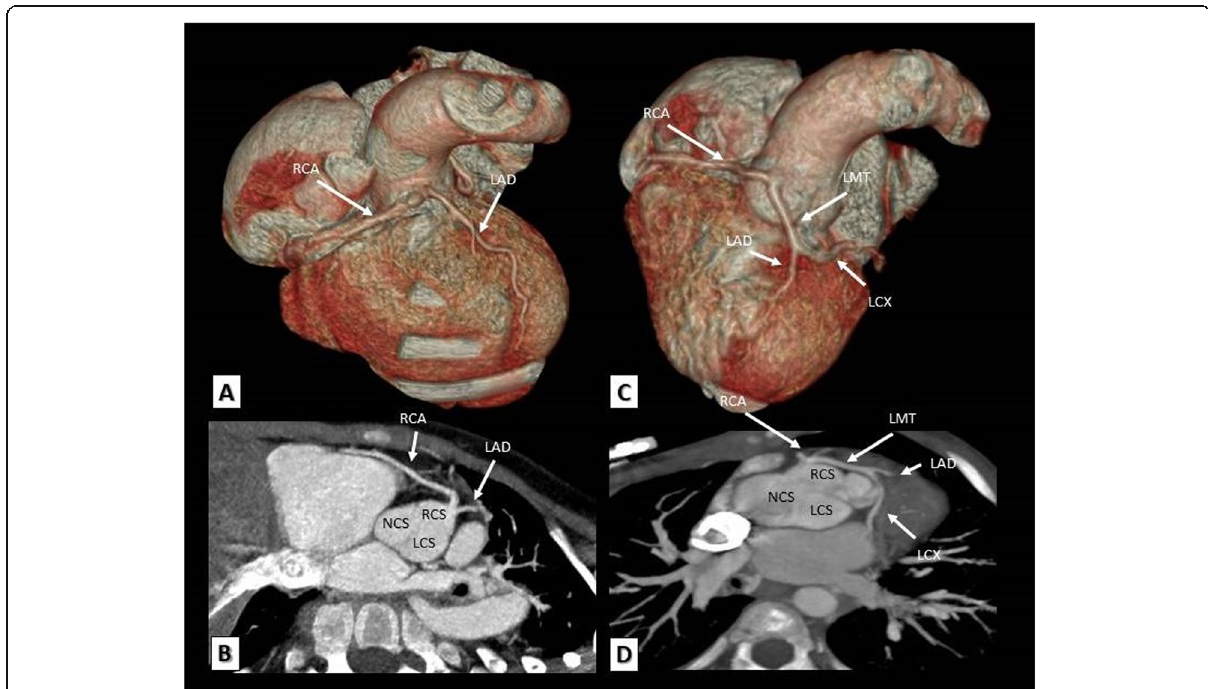
Fig. 4 a , b A TOF patient. a 3D VRT and b reformatted MDCT axial images showing the left anterior descending artery arising from the right coronary sinus and crossing the RVOT anteriorly to reach the anterior inter-ventricular groove. c , d Another TOF patient. c A VR and d a reformatted MDCT axial images showing a long left main trunk originating from the right coronary artery and crossing the RVOT anteriorly before it bifurcates to left anterior descending and left circumflex coronary arteries. LAD, left anterior descending; RCA, right coronary artery; LMT, left main trunk; LCX, left circumflex coronary artery; RCS, right coronary sinus; LCS, left coronary sinus; NCS, non-coronary